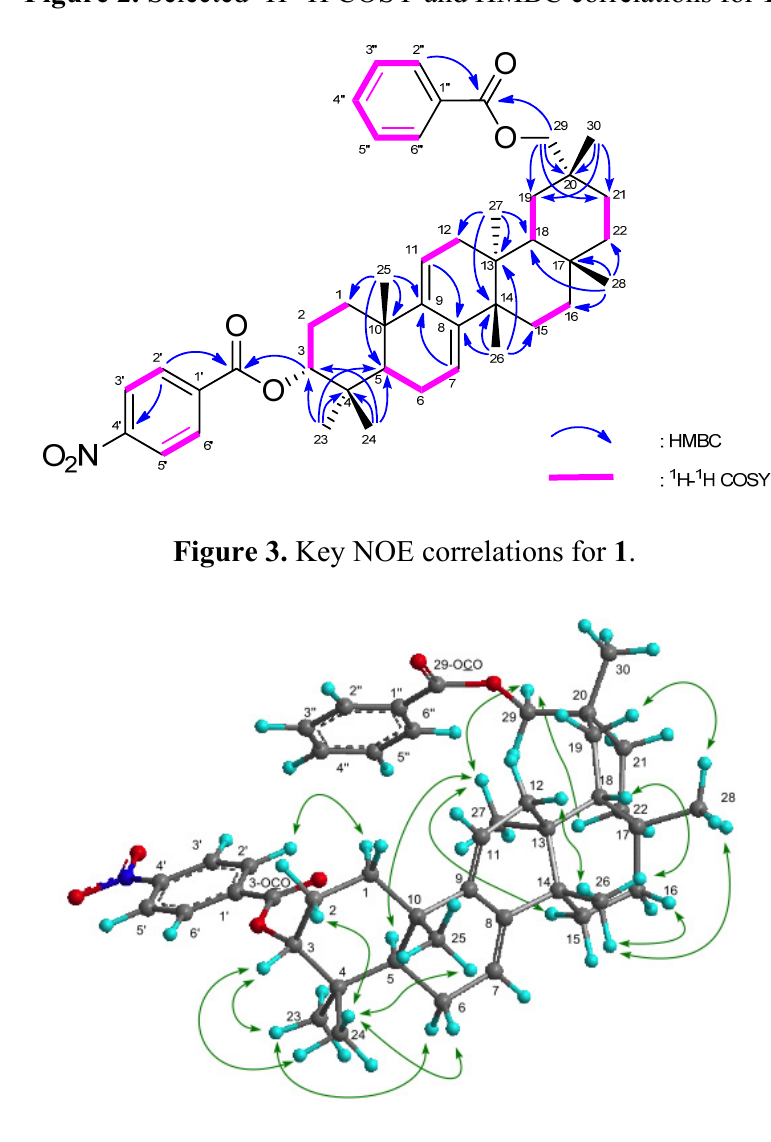
Figure 2. Selected 1 H- 1 H COSY and HMBC correlations for 1 .